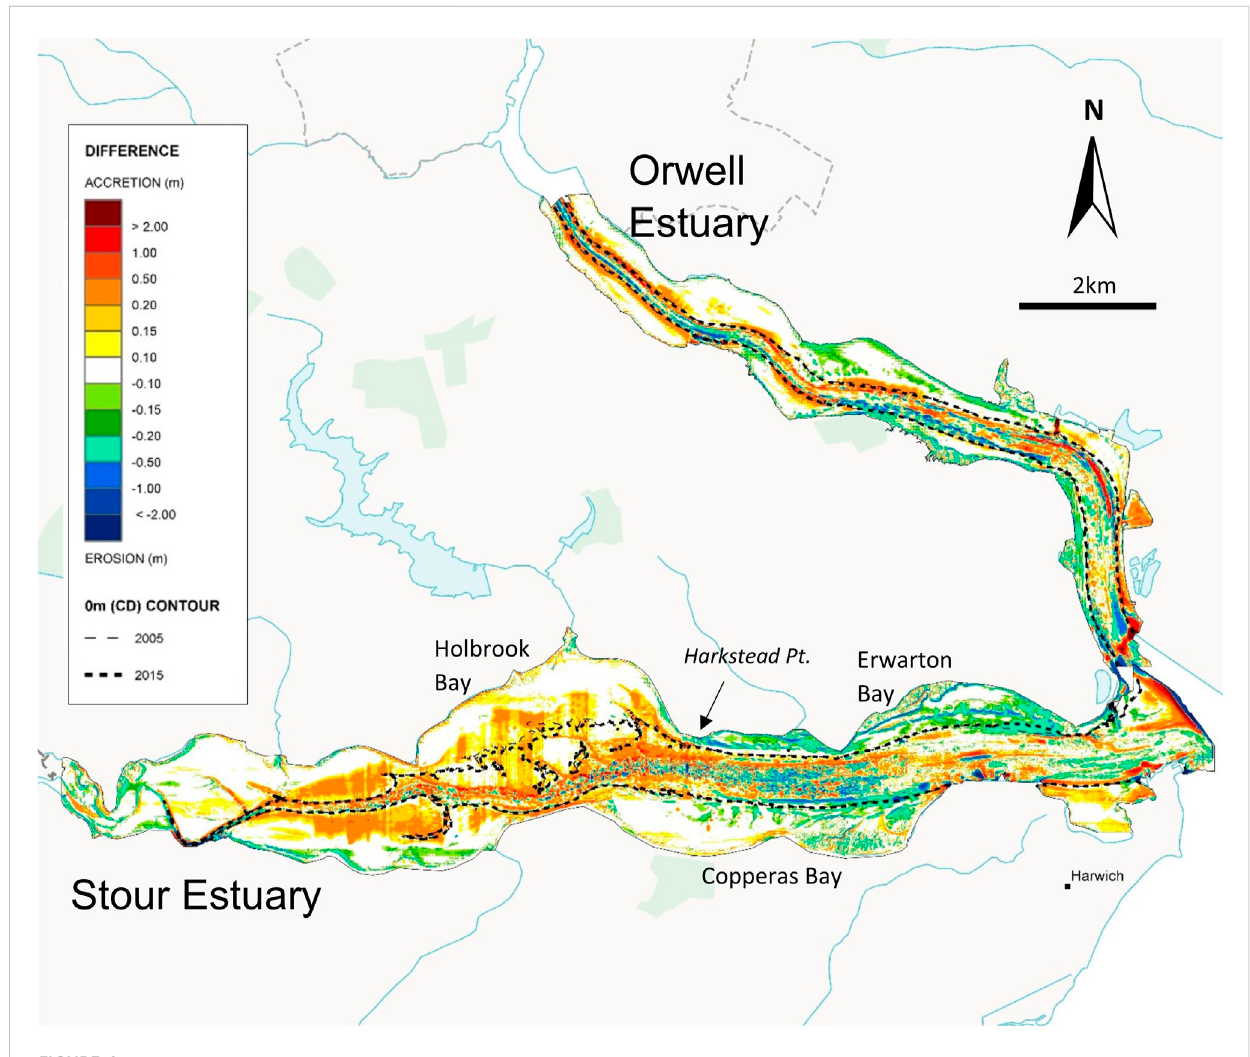
FIGURE 4 Measured change in bathymetry over the period 2005 –